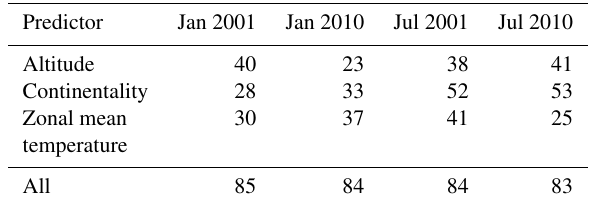
Table 1. Whole-domain averages of spatial variance explained by single predictors (%) for monthly mean temperature and 4 tested months. In the bottom row the results for the multiple regression model involving all predictors are